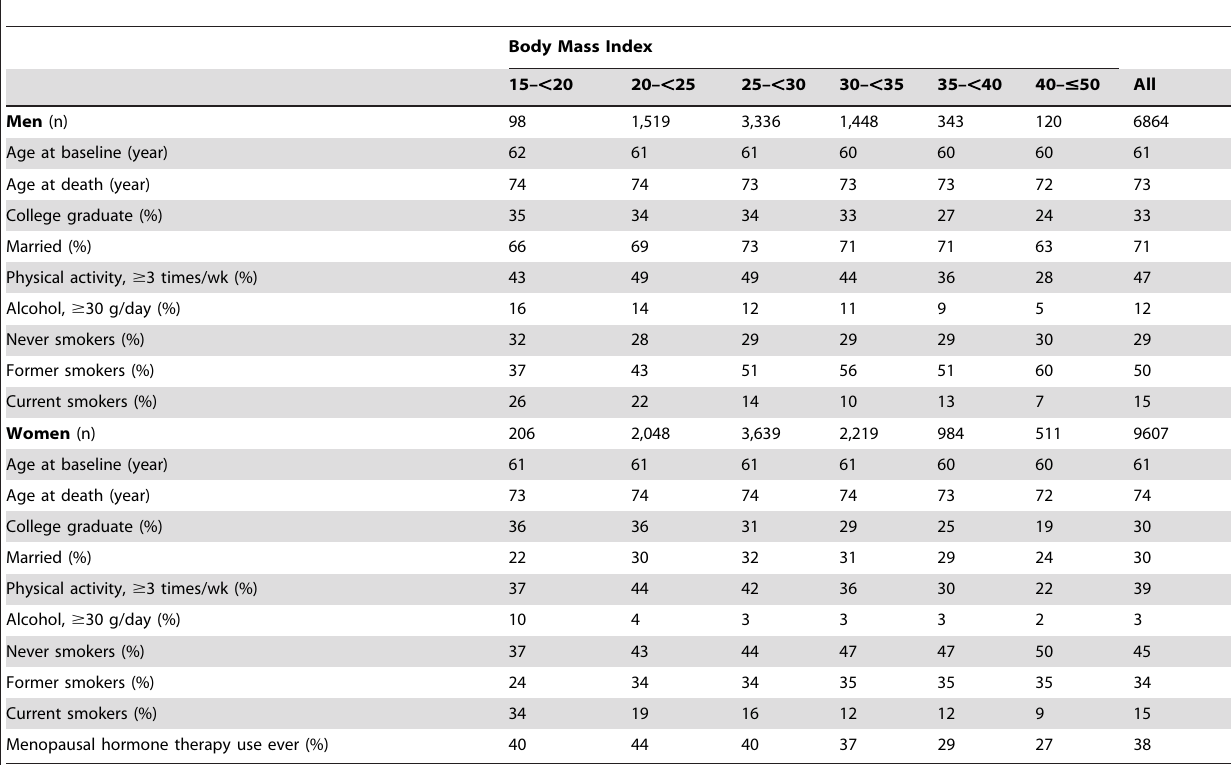
Table 1. Characteristics of non-Hispanic black men and women in the NIH-AARP Diet and Health